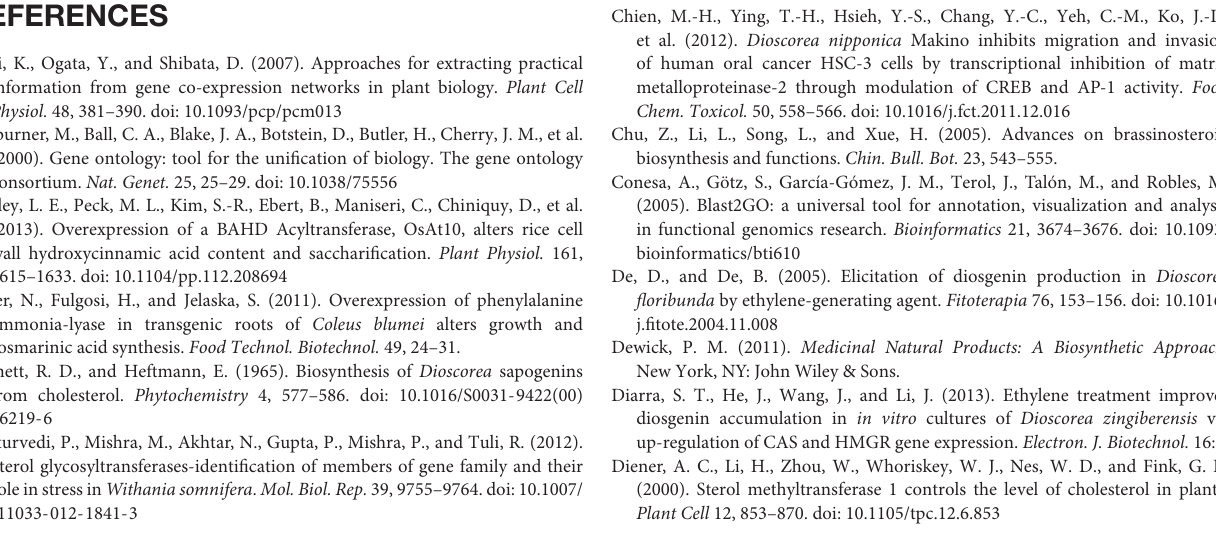
FIGURE S1 | Standard curves for the content determination via LC-MS/MS analysis. FIGURE S2 | Parameter selection in the construction of a scale-free co-expression network. TABLE S1 | The distribution of percent length coverage for the top matching database entries TABLE S2 | Responsive transcriptional factors induced by MeJA